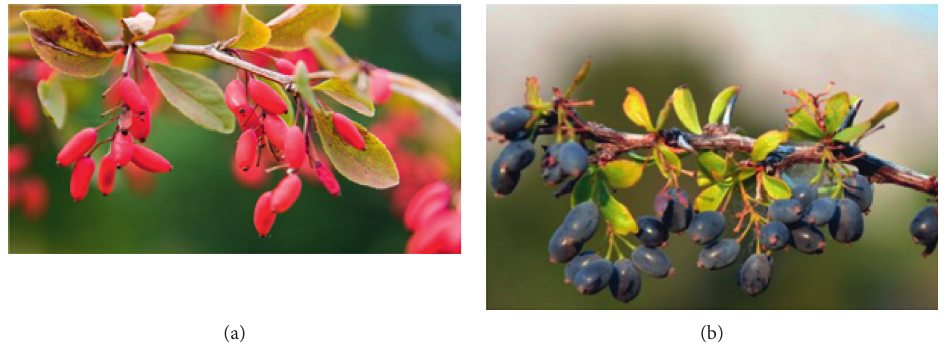
Figure 1: Fruits of Berberis vulgaris L. (a) and Berberis crataegina DC.